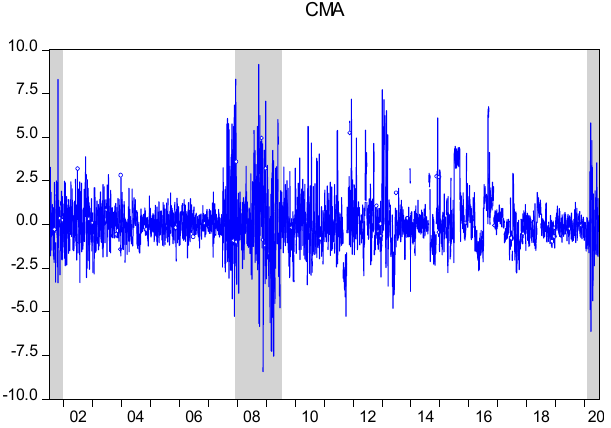
Figure 4. Time series variation in CMA premiums.